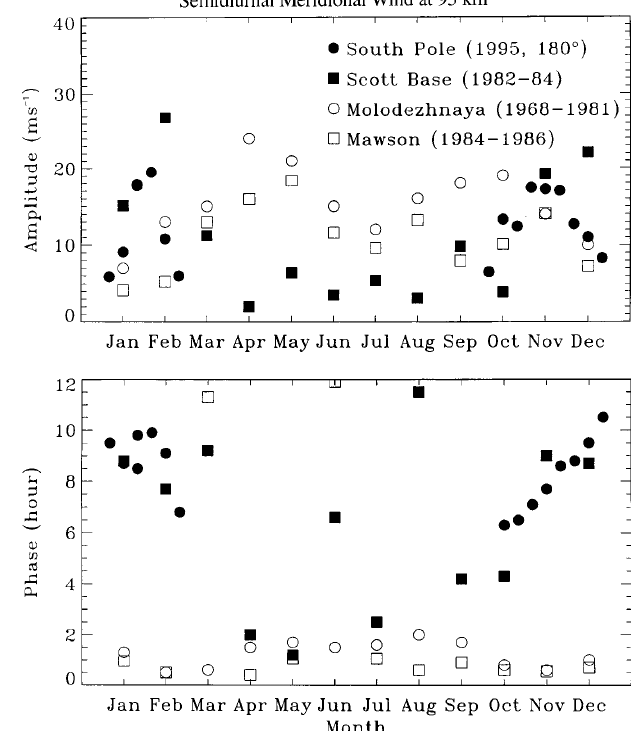
Fig. 7. Climatological amplitudes and phases (local times of maxima) of the semidiurnal oscillation in meridional wind at 95 km from four Antarctic stations. The South Pole measurements ( filled circles ) correspond to 1995 in the 180 (cid:176) longitude azimuth direction, towards Scott Base (78 (cid:176) S, 170 (cid:176) E). The Scott Base data ( solid squares ) correspond to 1982–1984. The Molodezhnaya (68 (cid:176) S, 45 (cid:176) E) data ( open circles ) represent averages over the years 1968–1981, and the Mawson (67 (cid:176) S, 63 (cid:176) E) data ( open squares ) correspond